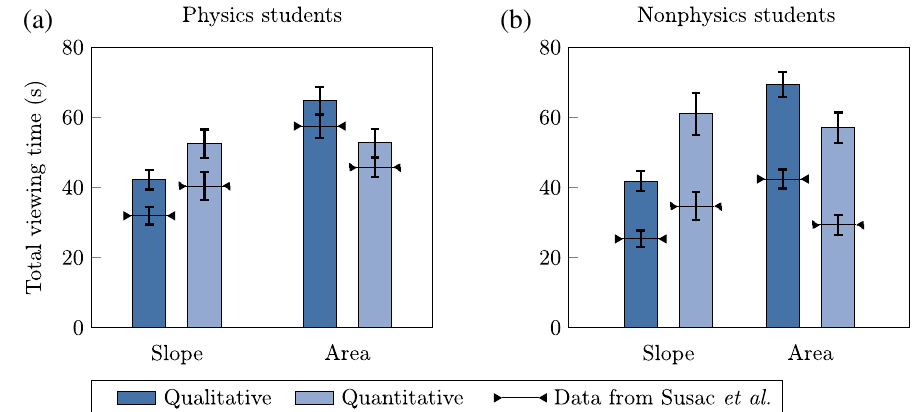
FIG. 6. Average total viewing time of (a) physics students and (b) nonphysics students on the qualitative and quantitative questions about graph slope and the area under a graph. The bar graphs represent data obtained in this study and refer to physics and economics students, whereas the triangles represent the data from Susac et al. , referring to physics and psychology students [7]. The error bars represent 1